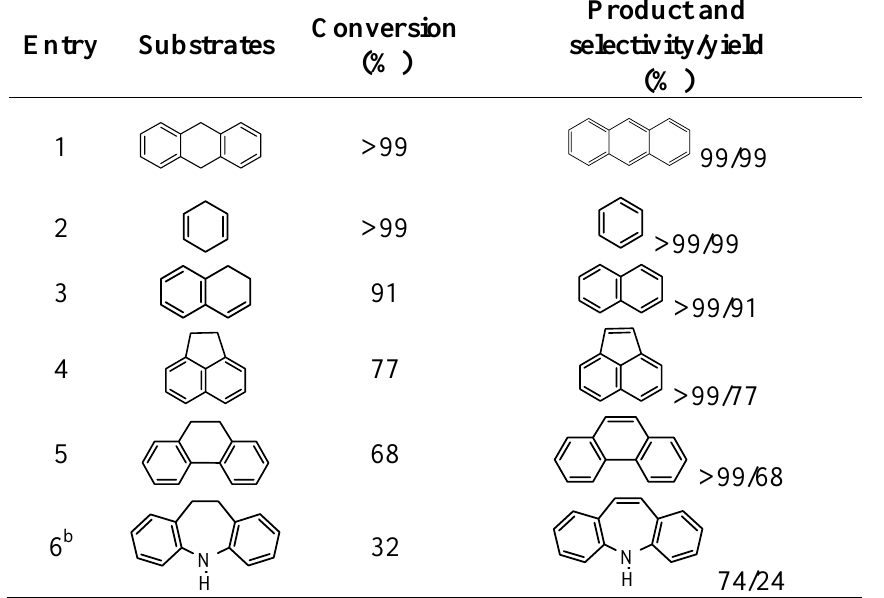
Table 3 . Oxidative dehydrogenation of different dihydroarenes with DDQ/NaNO